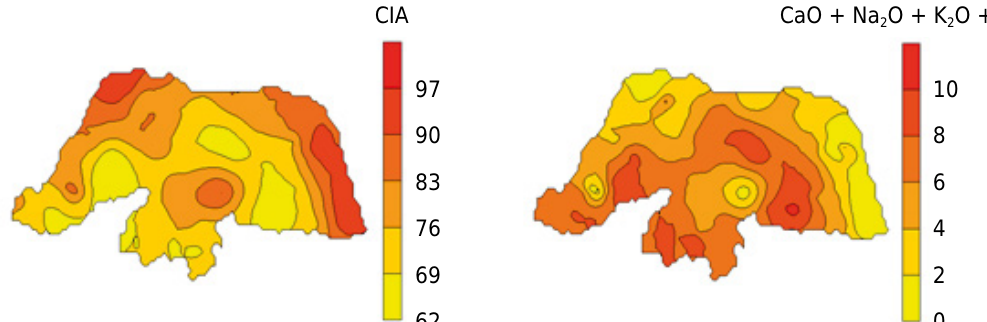
Figure 5. Spatial distribution of the chemical change index (CIA) and major elements in soils from Rio Grande do Norte,